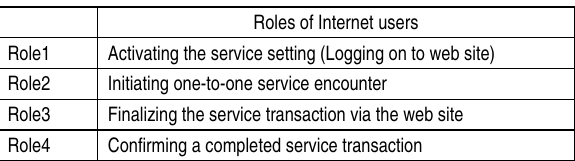
Table 1. Roles of Internet